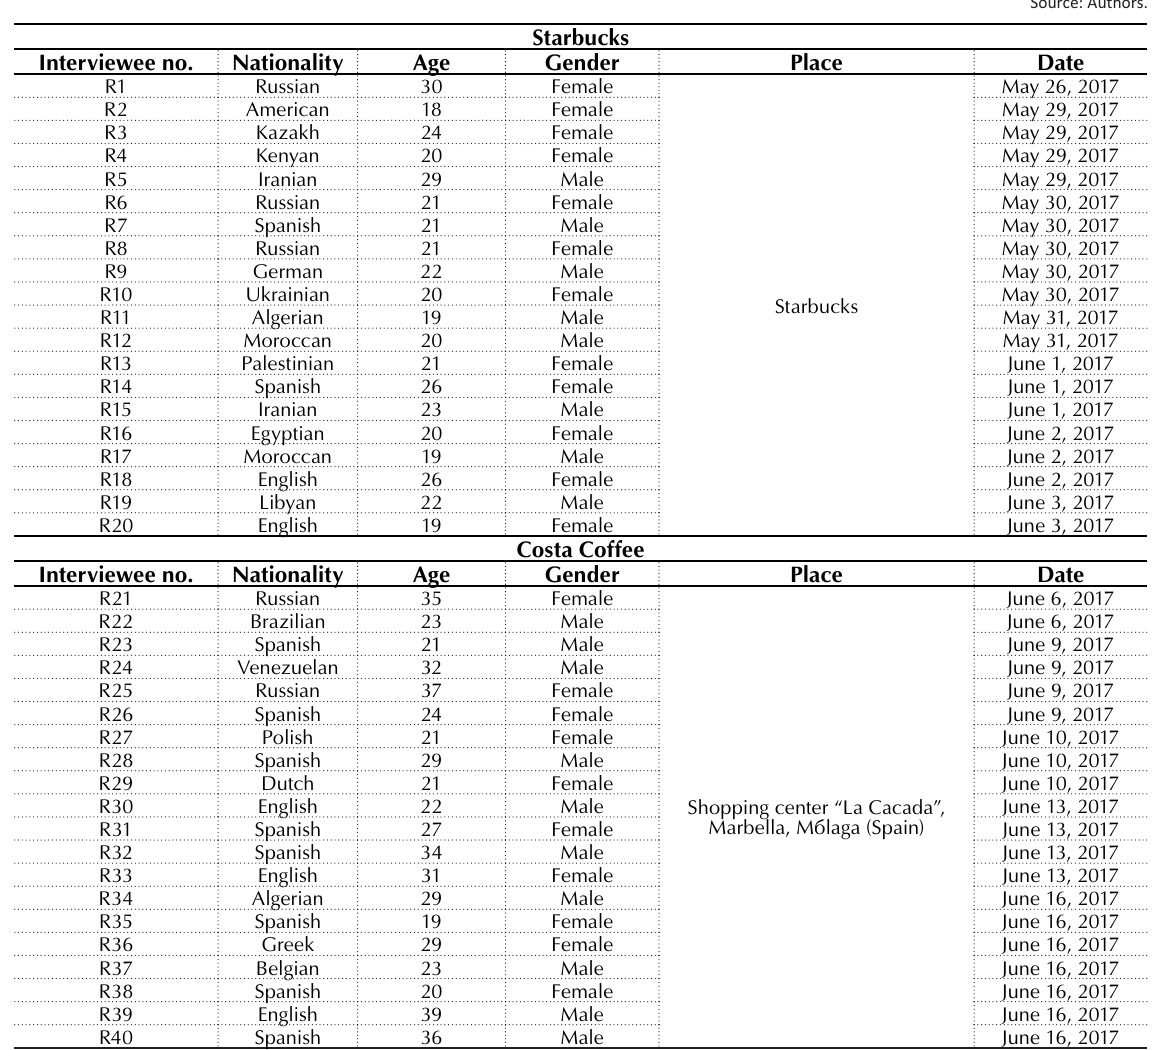
Table 1. Interviewees’